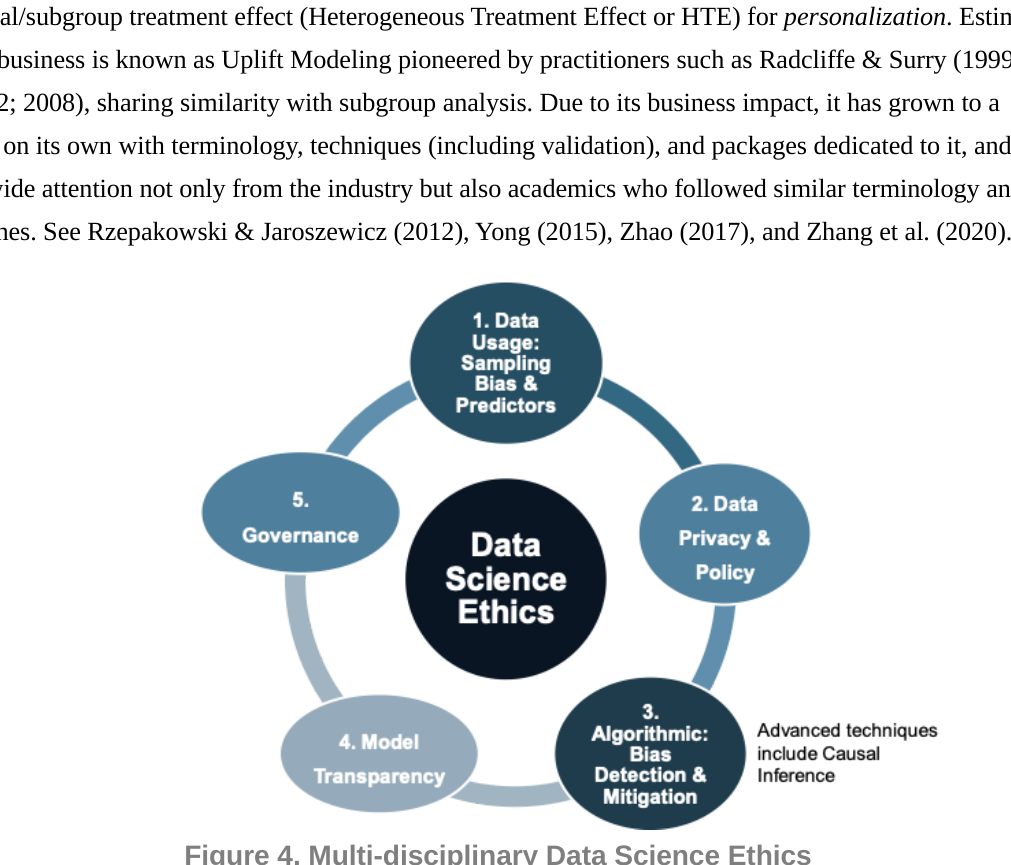
Figure 4. Multi-disciplinary Data Science